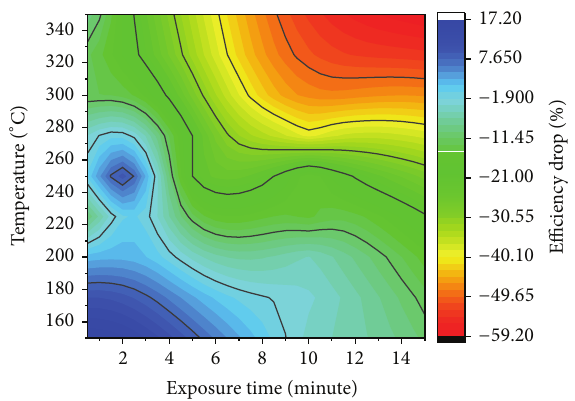
Figure 1: Effects on the efficiency of CIGS solar cells for different heat treatment conditions, as a function of time and temperature [2– 7].